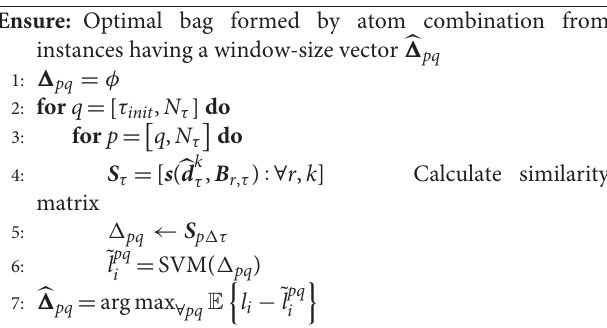
Algorithm 1: Expanded similarity of MIL